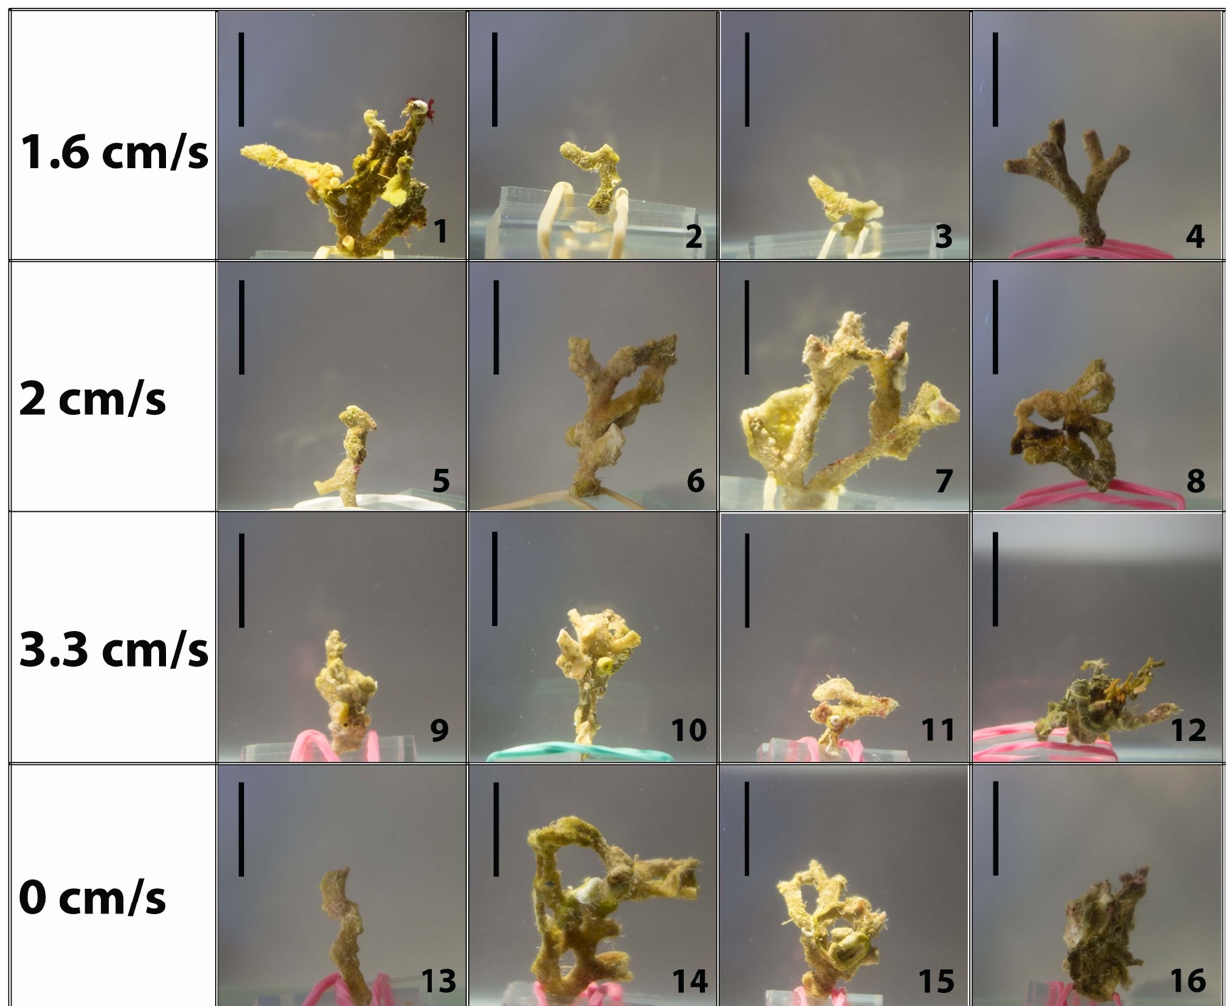
Figure 4. Photos of the 16 experimental colonies maintained in place by Plexiglas weights. Velocities are reported for each row. Scale bar 2.5 cm.